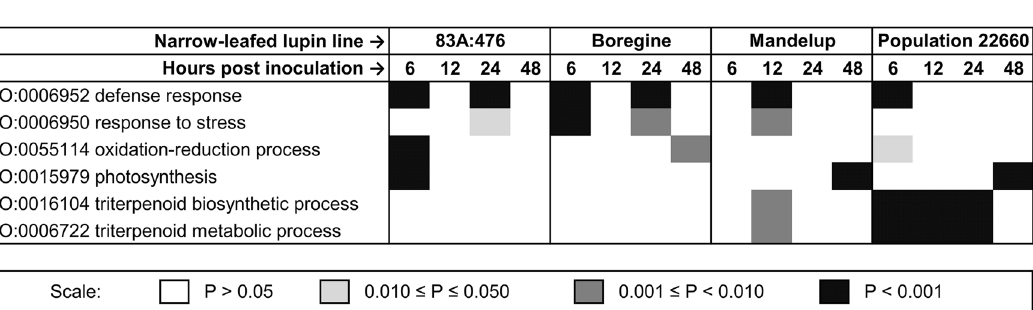
Figure 2. Selected biological process Gene Ontology terms significantly overrepresented in the annotation of differentially expressed genes during narrow-leafed lupin (NLL) transcriptomic response to inoculation with Colletotrichum lupini (strain Col-08, obtained in 1999 from the lupin field in Wierzenica, Poland). Analyzed NLL lines were as follows: 83A:476 (resistant, carrying homozygous Lanr1 allele), Boregine (resistant, unknown genetic background), Mandelup (moderately resistant, carrying homozygous AnMan allele), and Population 22660